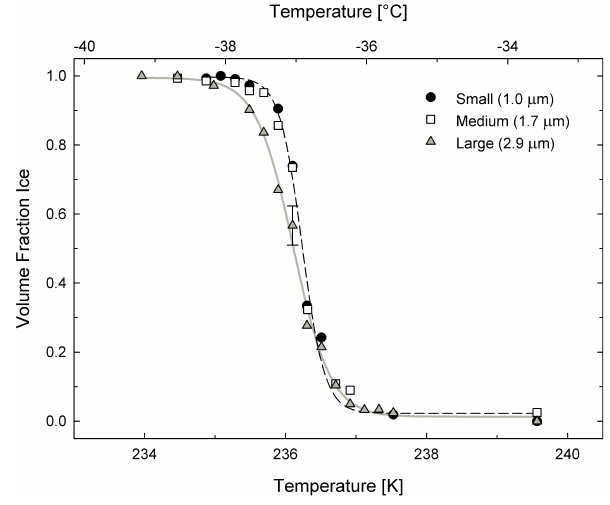
Fig. 5. Freezing curves determined from volume size distributions for experiments using each initial droplet size. Solid and dashed lines are provided to guide the eye and facilitate estimates of the homogeneous nucleation temperature from the freezing